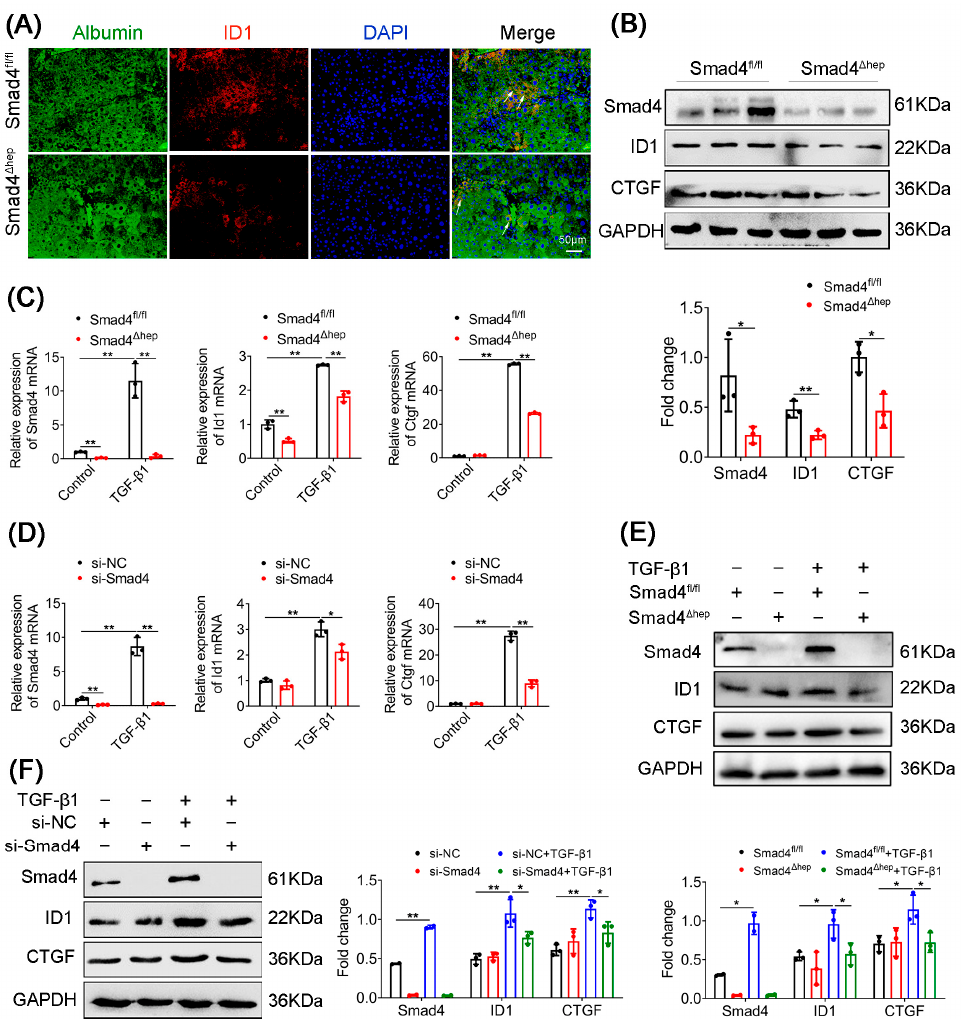
Figure 5. Hepatocyte-specific Smad4 deficiency inhibited the expression of ID1 and CTGF. Smad4 fl/fl and Smad4 ∆ hep mice were treated with CCl 4 for 4 weeks to establish the liver fibrosis model ( n = 6 per group). Primary hepatocytes were isolated from Smad4 fl/fl and Smad4 ∆ hep mice and then treated with TGF- β 1 (5 ng/mL) for 24 h. AML-12 cells were transfected with control siRNA or Smad4 siRNA, respectively, and then treated with TGF- β 1 (5 ng/mL) for 24 h. ( A ) Double staining of Albumin (green) and ID1 (red) in fibrotic liver tissues (scale bars: 50 µ m) and statistical analysis. Arrowhead indicated the double-positive cells. ( B ) Western blotting analysis of protein levels of Smad4, ID1, and CTGF in fibrotic liver tissues. Smad4, ID1, and CTGF were normalized to GAPDH. ( C ) The mRNA levels of Smad4, ID1, and CTGF in primary hepatocytes were measured using real-time PCR analysis. ( D ) The mRNA levels of Smad4, ID1, and CTGF in AML-12 cells were measured using real-time PCR analysis. ( E ) Western blot analysis of protein levels of Smad4, ID1, and CTGF in primary hepatocytes. Smad4, ID1, and CTGF were normalized to GAPDH. ( F ) Western blot analysis of protein levels of Smad4, ID1, and CTGF in AML-12 cells. Smad4, ID1, and CTGF were normalized to GAPDH. * p < 0.05, ** p < 0.01.